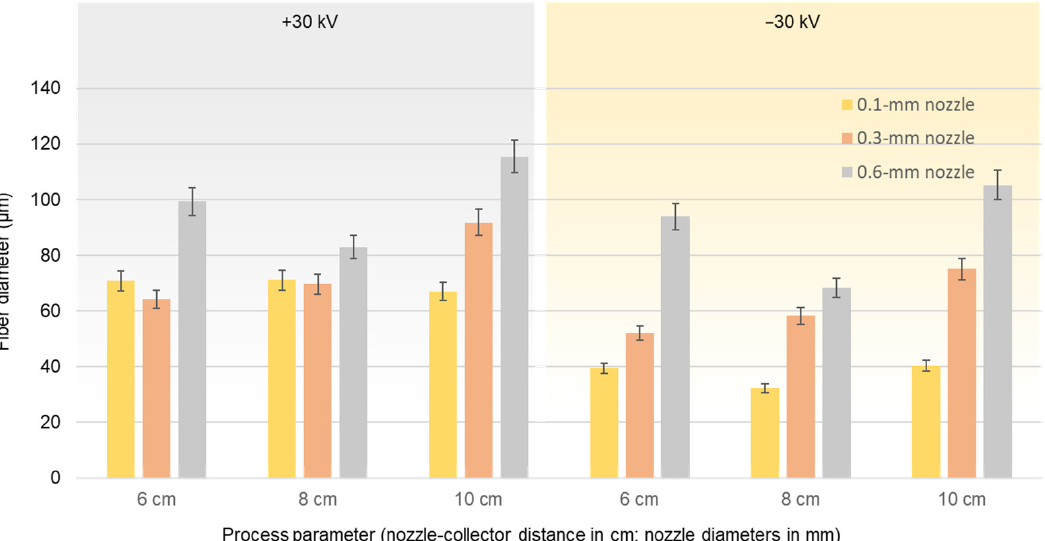
Figure 4. Diameter of PBS fibers produced with a throughput of 0.1 mL/min at a polymer melt temperature of 235 °C with three different nozzle-to-collector distances and nozzles of different diameters as indicated by the color key. We directly compared electric field strengths of +30 kV and − 30 kV. Data are presented as means ± standard deviation ( n = 100).